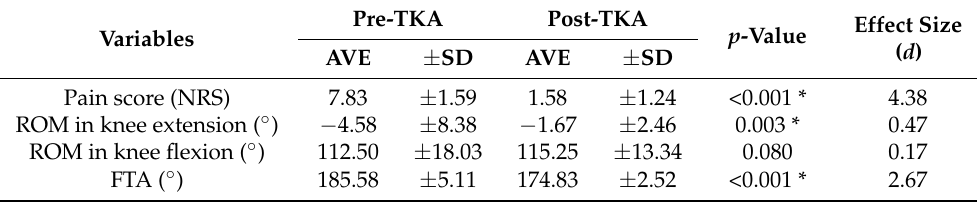
Table 1. Preoperative and postoperative characteristics of the